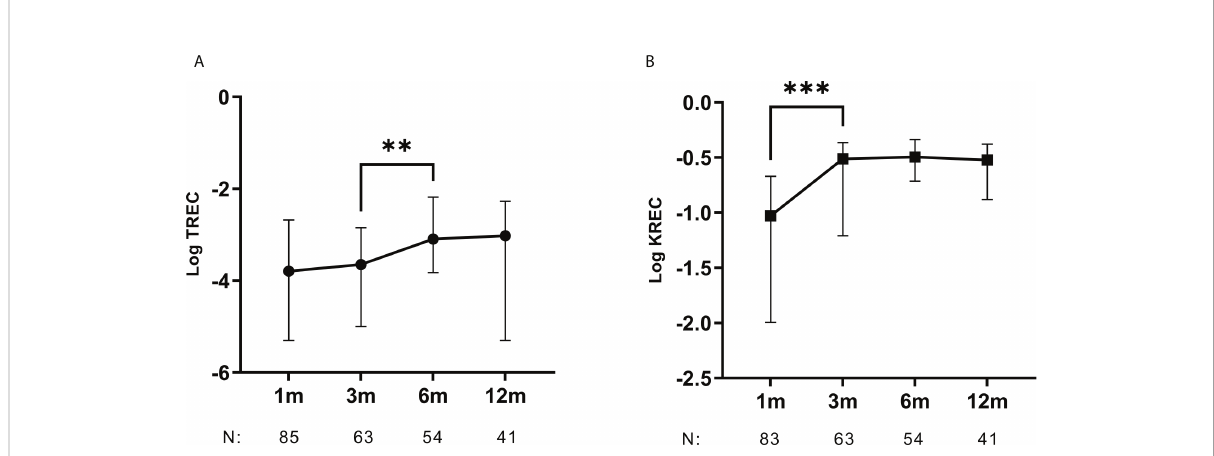
FIGURE 1 TREC and KREC levels increase within the fi rst months after HSCT. Kinetics for (A) TREC and (B) KREC levels from 1 to 12 months after HSCT. Median with whiskers for interquartile range. N: Number of samples analyzed at each time point. Mann-Whitney U-test. **p < 0.01, ***p < 0.001.